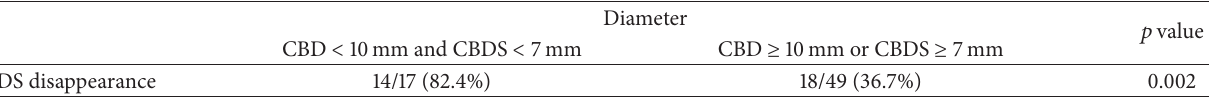
Table 4: Stone disappearance in patients with CBD < 10mm and CBDS < 7 mm.